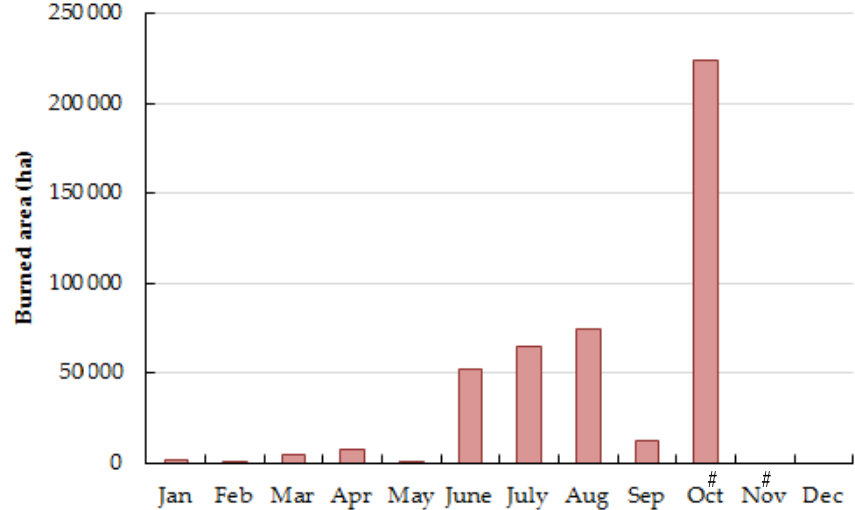
Figure 2. Levels of monthly total forest area (ha) burned in Portugal during 2017. # Data were not available